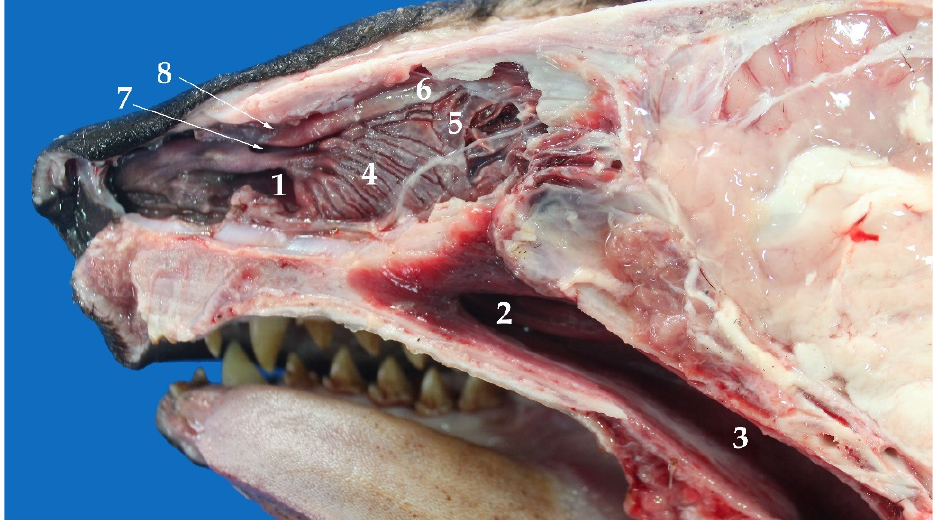
Figure 2. Lateral view of the left nasal cavity: (1) ventral nasal meatus; (2) choana; (3) nasopharynx; (4) ventral nasal conchae with parallel folds ( plicae parallelis ); (5) middle nasal conchae; (6) dorsal nasal conchae; (7) middle nasal meatus; (8) dorsal nasal meatus.